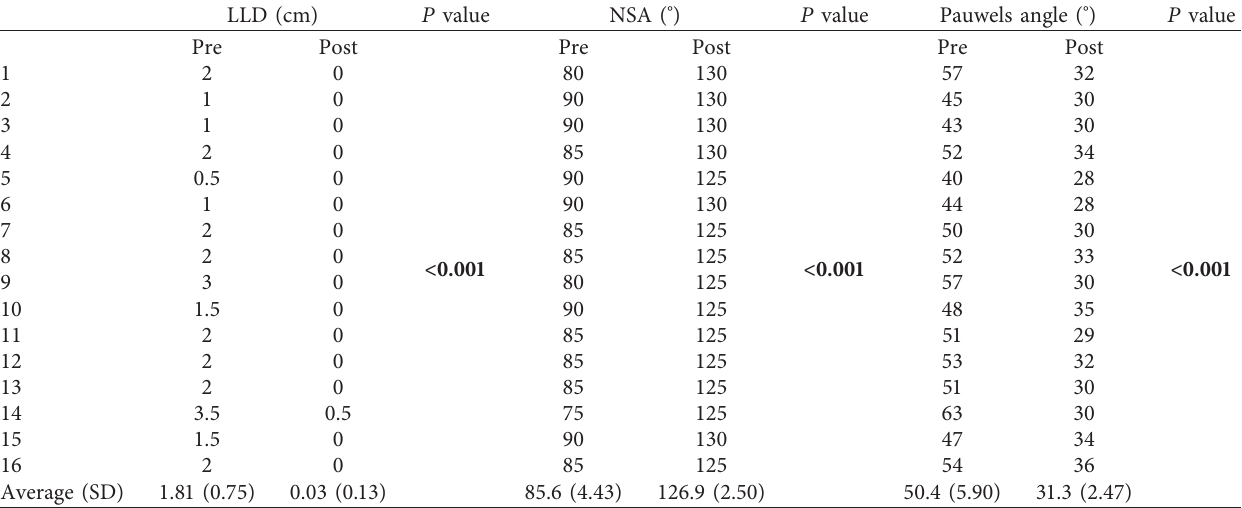
Table 2: Patients’ clinical data pre and postoperation.